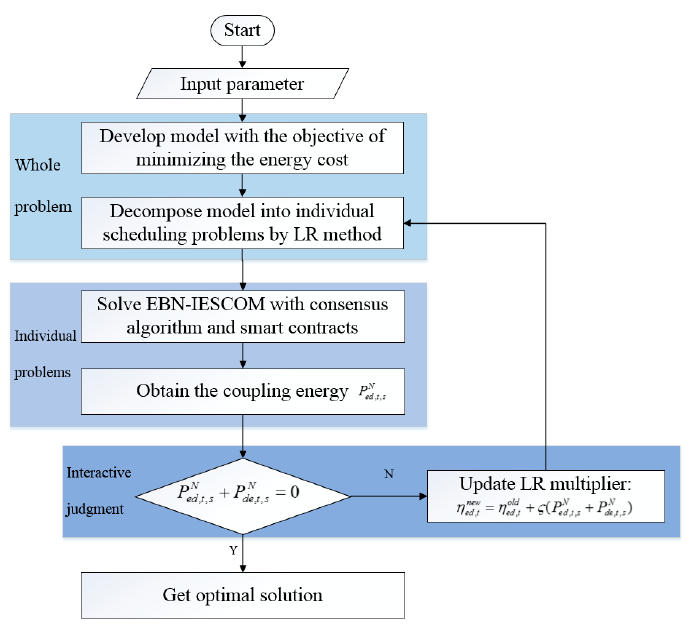
Figure 6. The flowchart of the proposed method. Table 3. Sell nodes in the EBN.